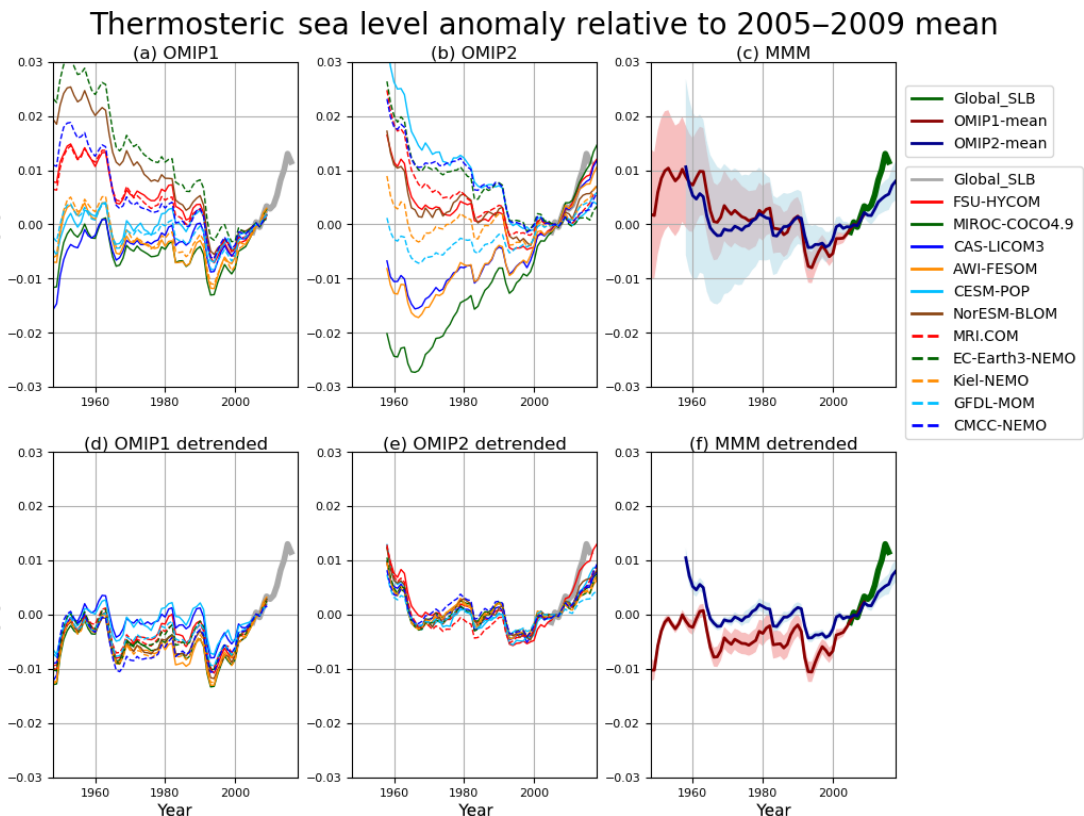
Figure 25. Time series of annual mean thermosteric sea level anomaly relative to 2005–2009 mean (m). (a) OMIP-1 and (b) OMIP-2. (c) Multi-model mean (lines) and spread defined as 1 standard deviation (shades) of OMIP-1 (red) and OMIP-2 (blue). Panels (d–f) are the same as (a) – (c) except that linear trend is subtracted from each model. Grey lines in panels (a) , (b) , (d) , and (e) , and green lines in panels (c) and (f) are adopted from WCRP Global Sea Level Budget Group